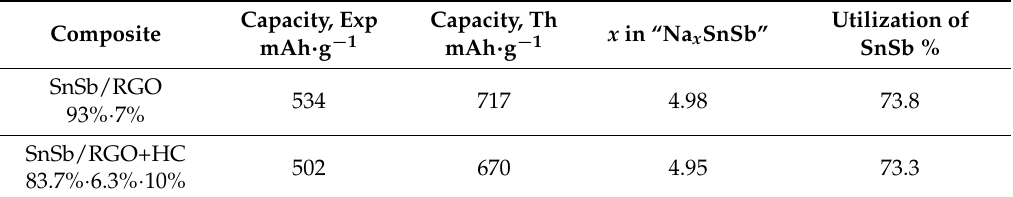
Table 1. Comparison between the experimentally observed and theoretical capacity of (SnSb/GO) and